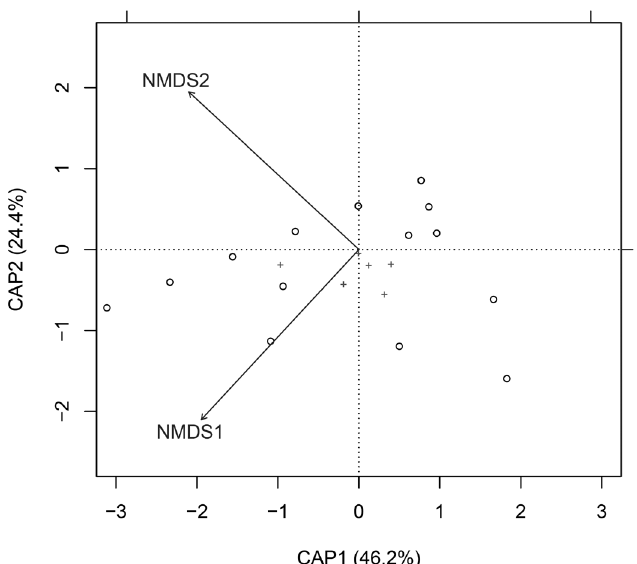
Figure 4. A canonical analysis of principal coordinates (CAP) with Euclidean distance to show association of adult assemblage with NMDS1 and NMDS2 representing microhabitat conditions. The circle represents belt transects and cross represents